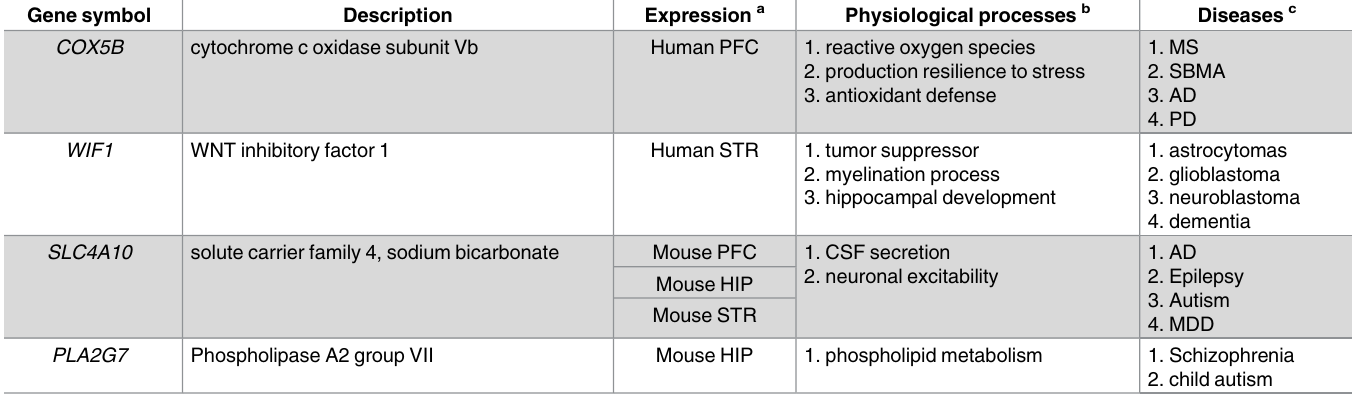
a The species and brain regions that the identified orthologous genes are highly expressed in. b The relevant physiological processes that the species-specific expressed orthologous genes are involved in. c The associated diseases caused by the dysfunctions of the corresponding species-specific